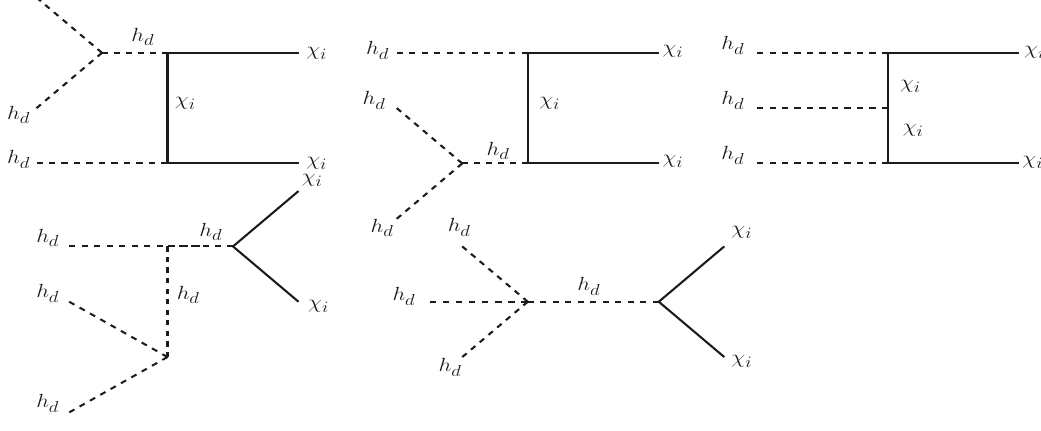
Figure 22 . Feynman diagrams for h d h d h d → χ